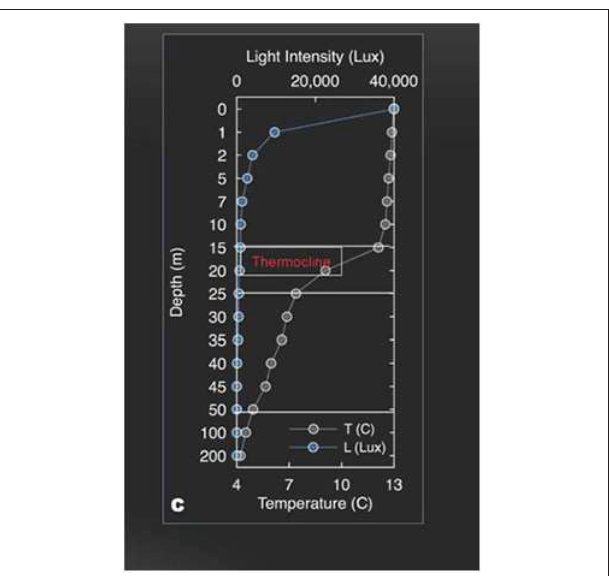
FIGURE 4 | The NASA/ASTEP/SETI Planetary Lake Lander survey data on physico-chemical parameters of the water column from December 2012 to December 2013 ( Cabrol et al., 2015): the figure is a sample profile showing variation in light intensity (Lux) and temperature ( ◦ C) in relation to depth (to